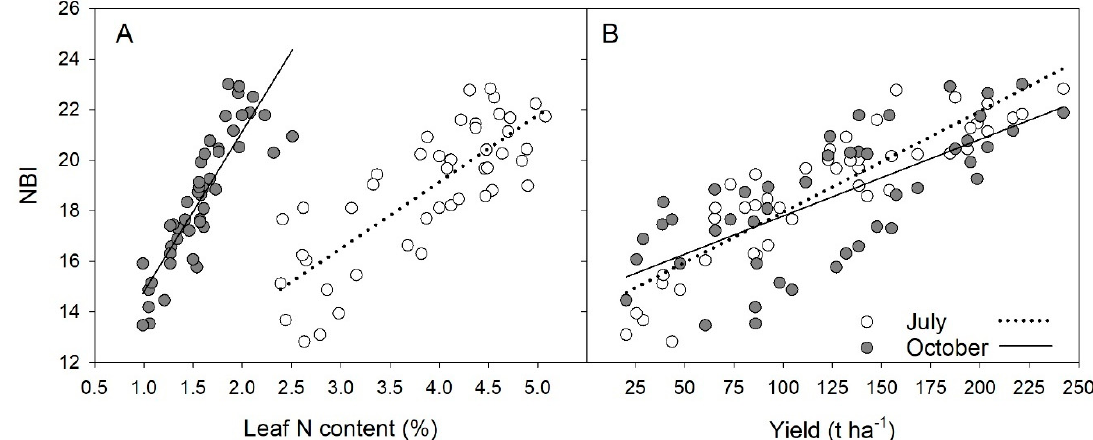
Figure 3. Relationship between NBI and cabbage leaf N content ( A ) and between NBI and total cabbage yield ( B ) for the two consecutive years of the experiment grouped according to the sampling date, in July (39 and 49 DAT, in 2018 and 2019, respectively) and October (136 and 126 DAT, in 2018 and 2019, respectively). Table 3. Coefficient of determination (R 2 ) for the linear correlation between NBI and single-year cabbage yield at two growing stages.